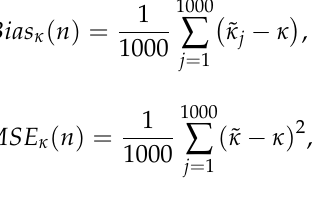
Fig. 10. Behaviour of MSE of estimators with di⁄erent methods under parametric set I 17